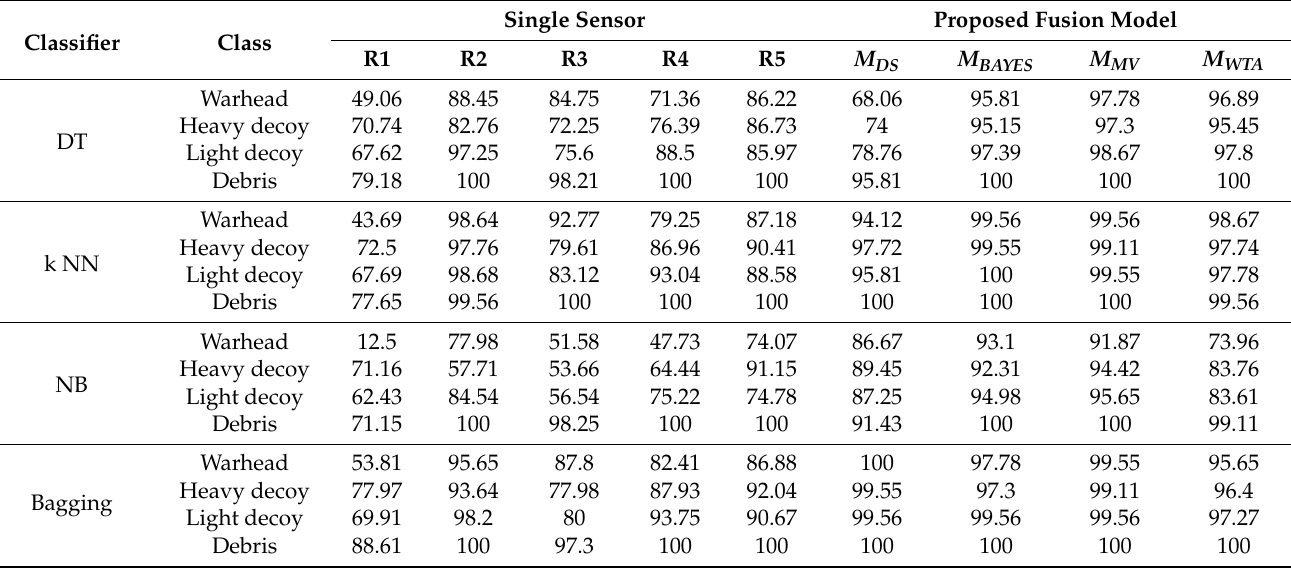
Table 7. F1-scores of four classes in the proposed model with ICA (in